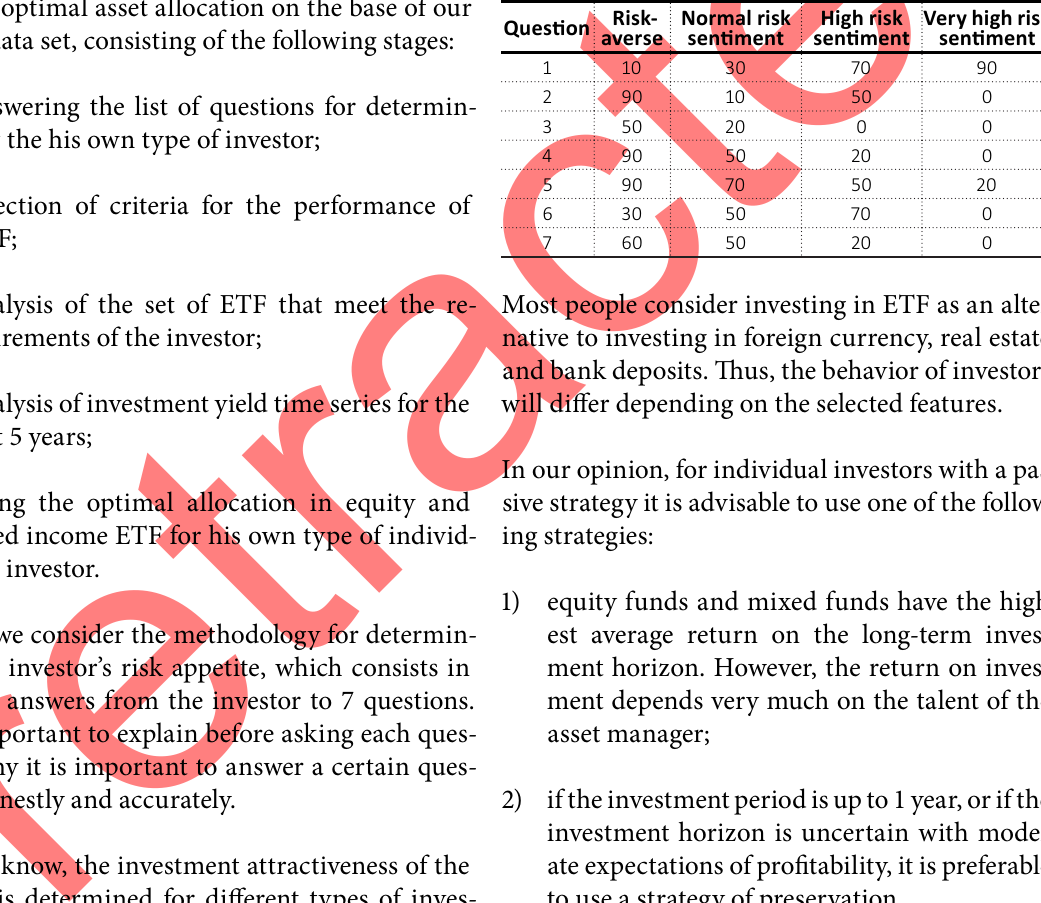
Table 1. Points for each answer and level of risk Source: Authors’